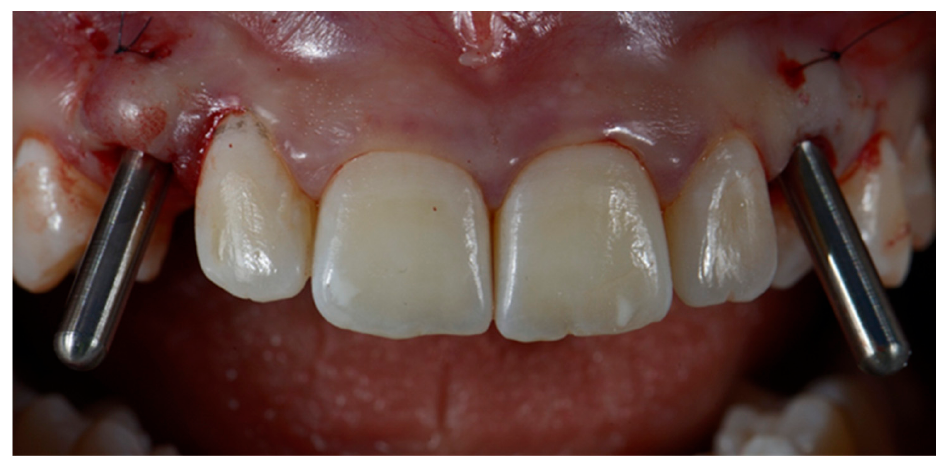
Figure 3. Surgical guide template.